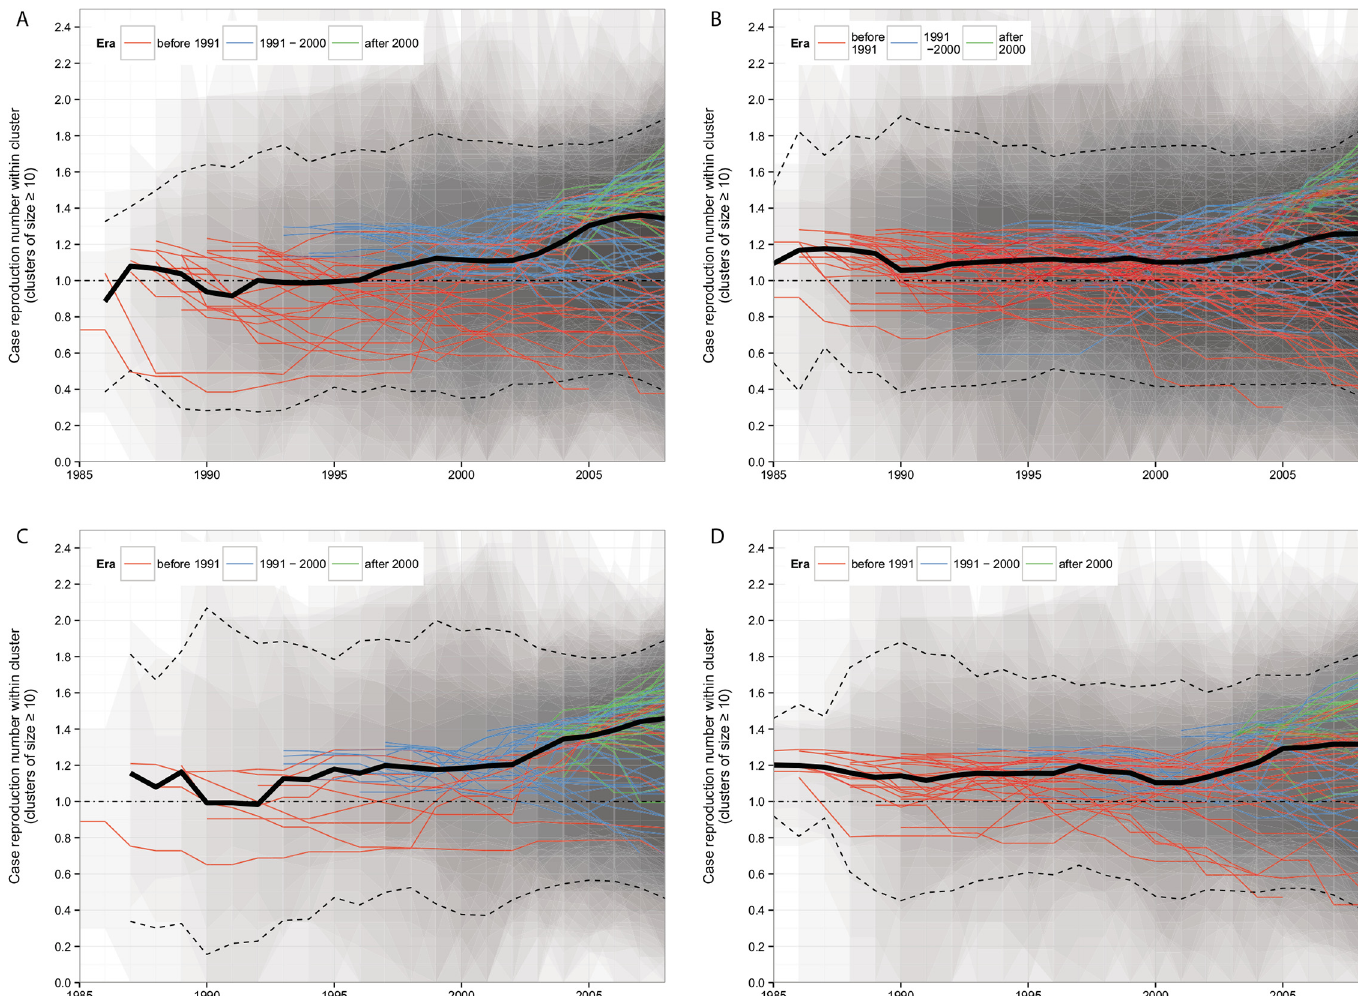
Fig 6. Estimated case reproduction number over time for all MSM-majority transmission clusters of (cid:1) 10 cases. The solid lines show the mean R t estimate for each transmission cluster. The bold black line is the mean R t of all clusters, with the 95% confidence interval shown by the dotted lines. The shaded areas show the 95% confidence intervals for each transmission cluster: darker areas indicate overlapping intervals across different transmission clusters. Transmission clusters are shown in red if their first sequence appeared before 1991, in blue if their first sequence appeared between 1991 and 2000, and in green if their first diagnosed case appeared after 2000. The black horizontal dotted line represents the threshold value R t = 1. (A) Main analysis. (B) Sensitivity analysis for a looser cluster definition. (C) Sensitivity analysis for a more stringent cluster definition. (D) Sensitivity analysis for the clusters defined under a single linkage branch length